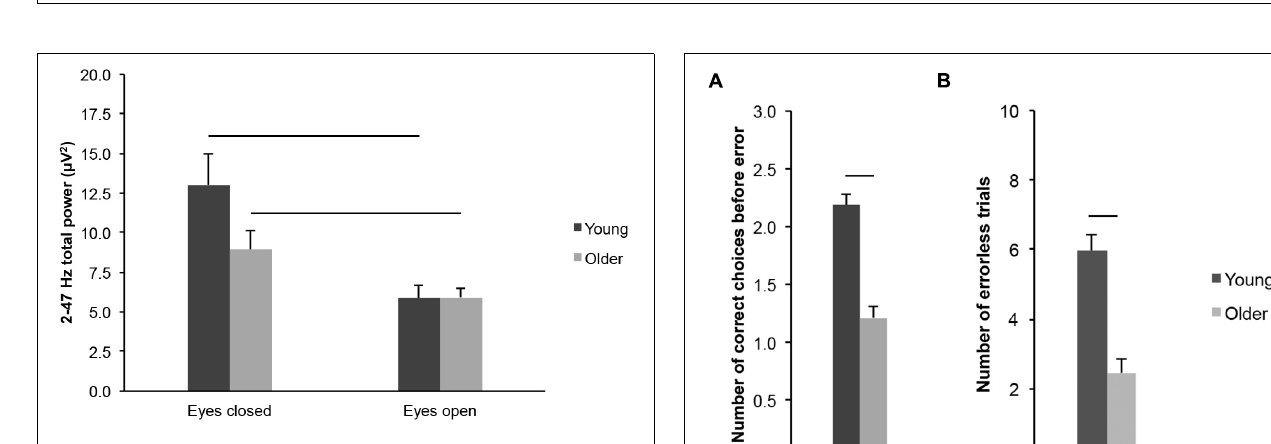
FIGURE 5 | Gamma-band activity measured across the scalp in healthy 20–30-year-old (Young; dark gray bars) and 65–75-year-old (Older; light gray bars) adults. (A) Gamma absolute power. (B) Gamma relative power. Average ± SEM. Horizontal bars indicate statistically significant differences between age groups or eye conditions ( p < 0.05).